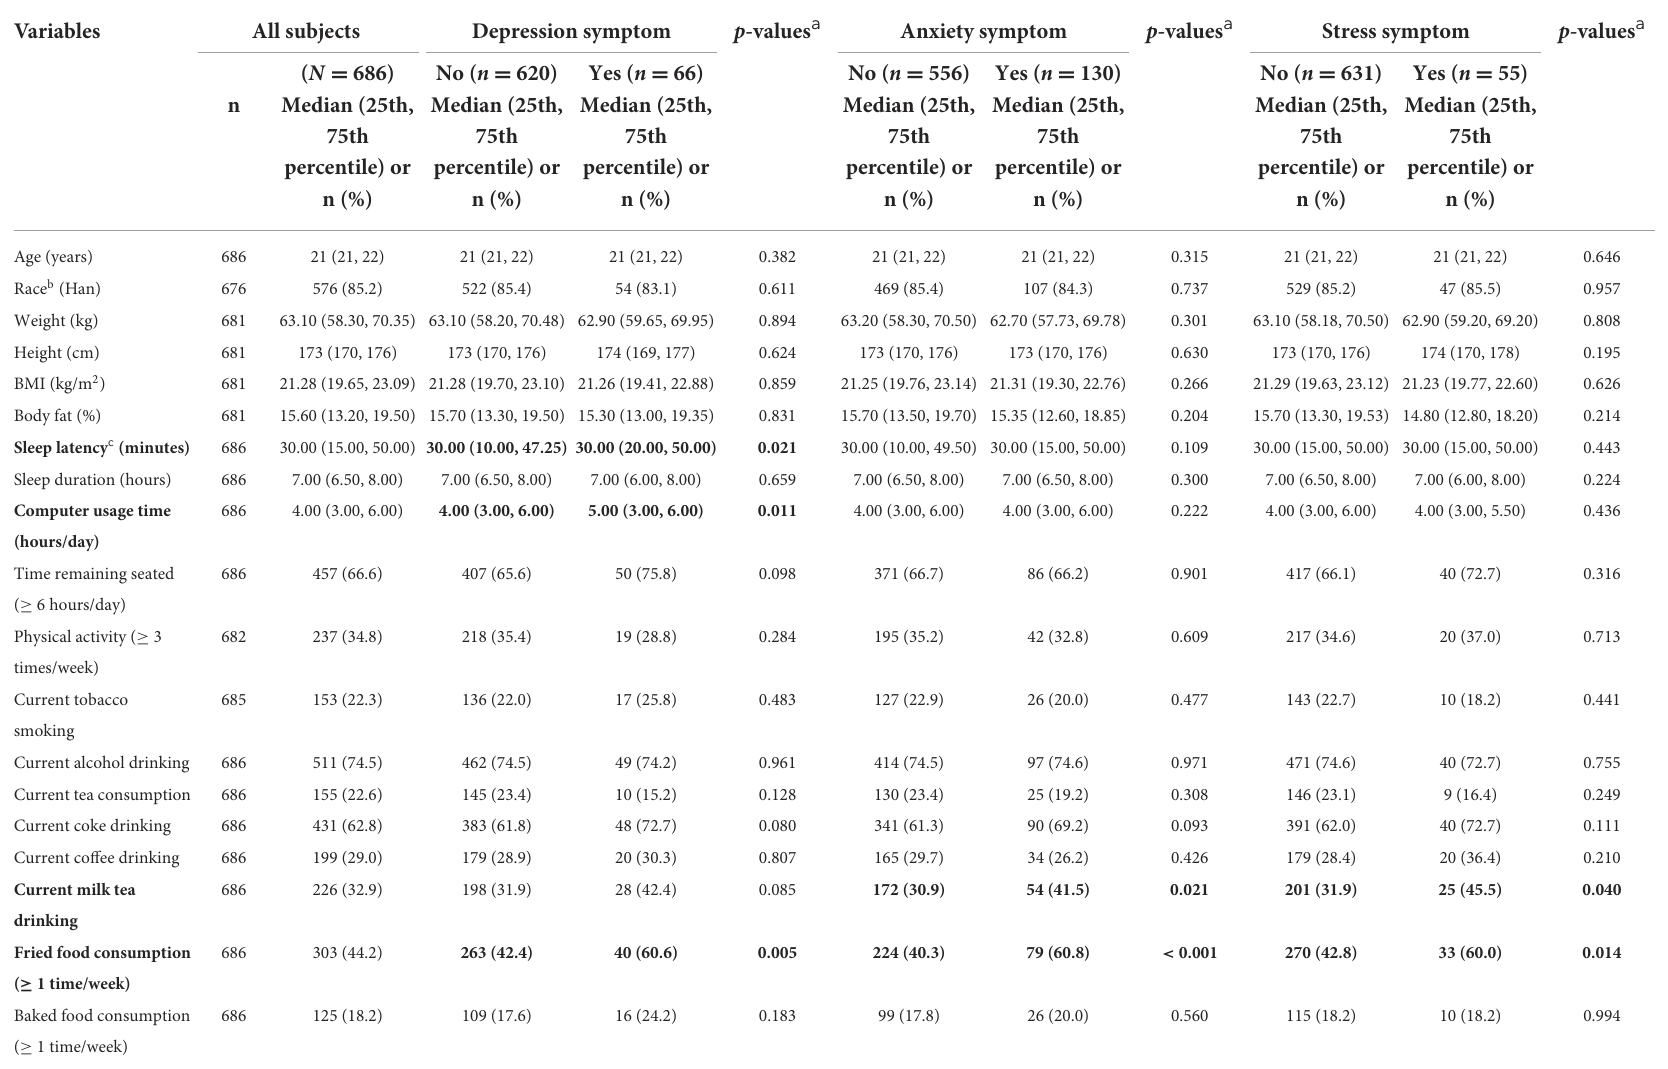
TABLE 1 The distribution of demographic characteristics and lifestyle factors according to the status of depression, anxiety, and stress symptoms among 686 male college students at baseline (year